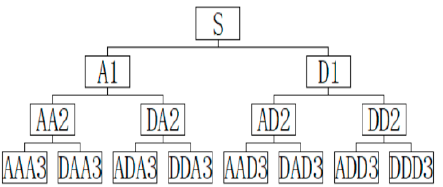
Figure 4. Three-level wavelet packet decomposition node diagram.